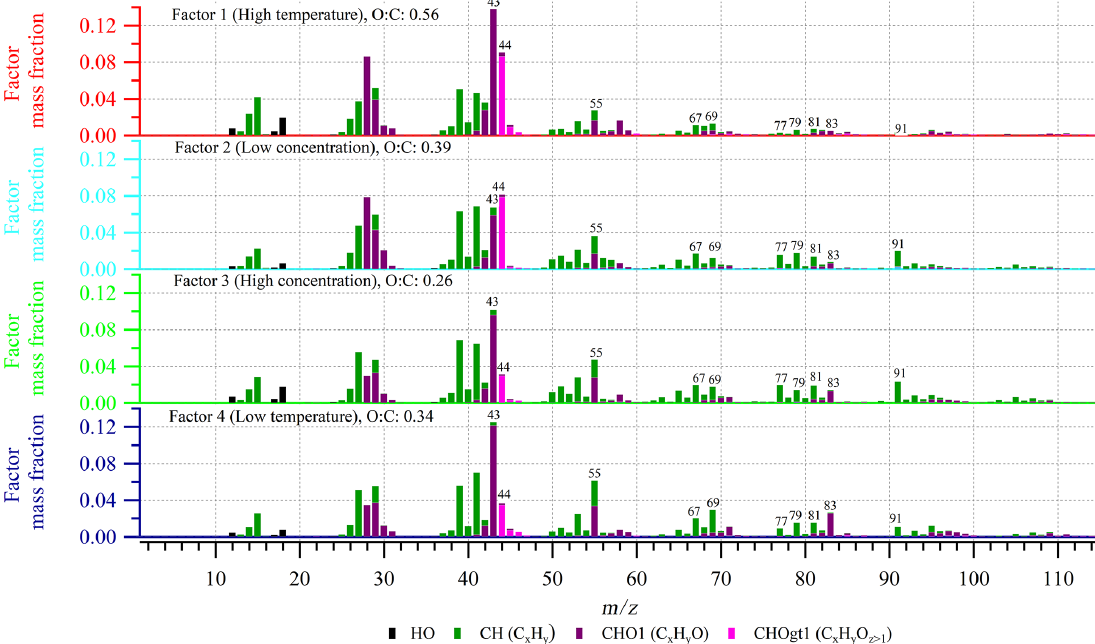
Figure 3. Mass spectra of the four factors from the PMF analysis (see also Fig. 2 and Table 2) of the combined dataset of experiments 1.1–1.5 and 3.1–3.3. gt denotes greater